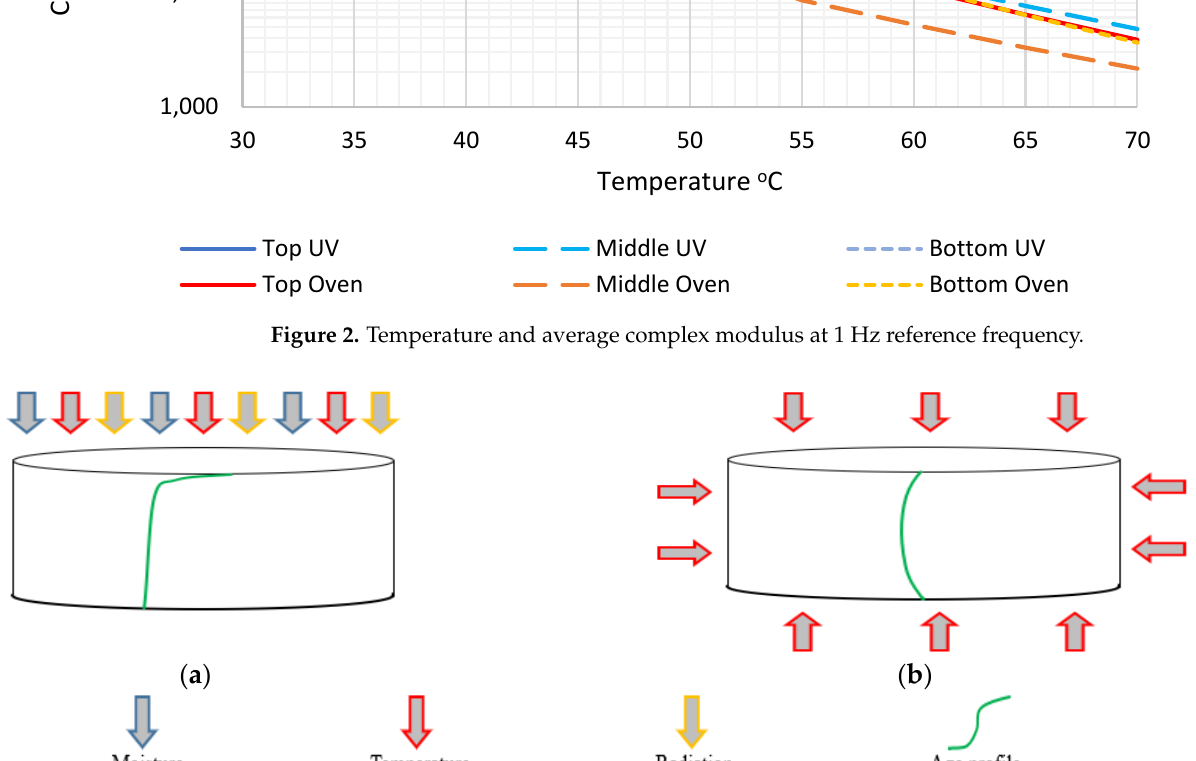
Figure 2. Temperature and average complex modulus at 1 Hz reference frequency.